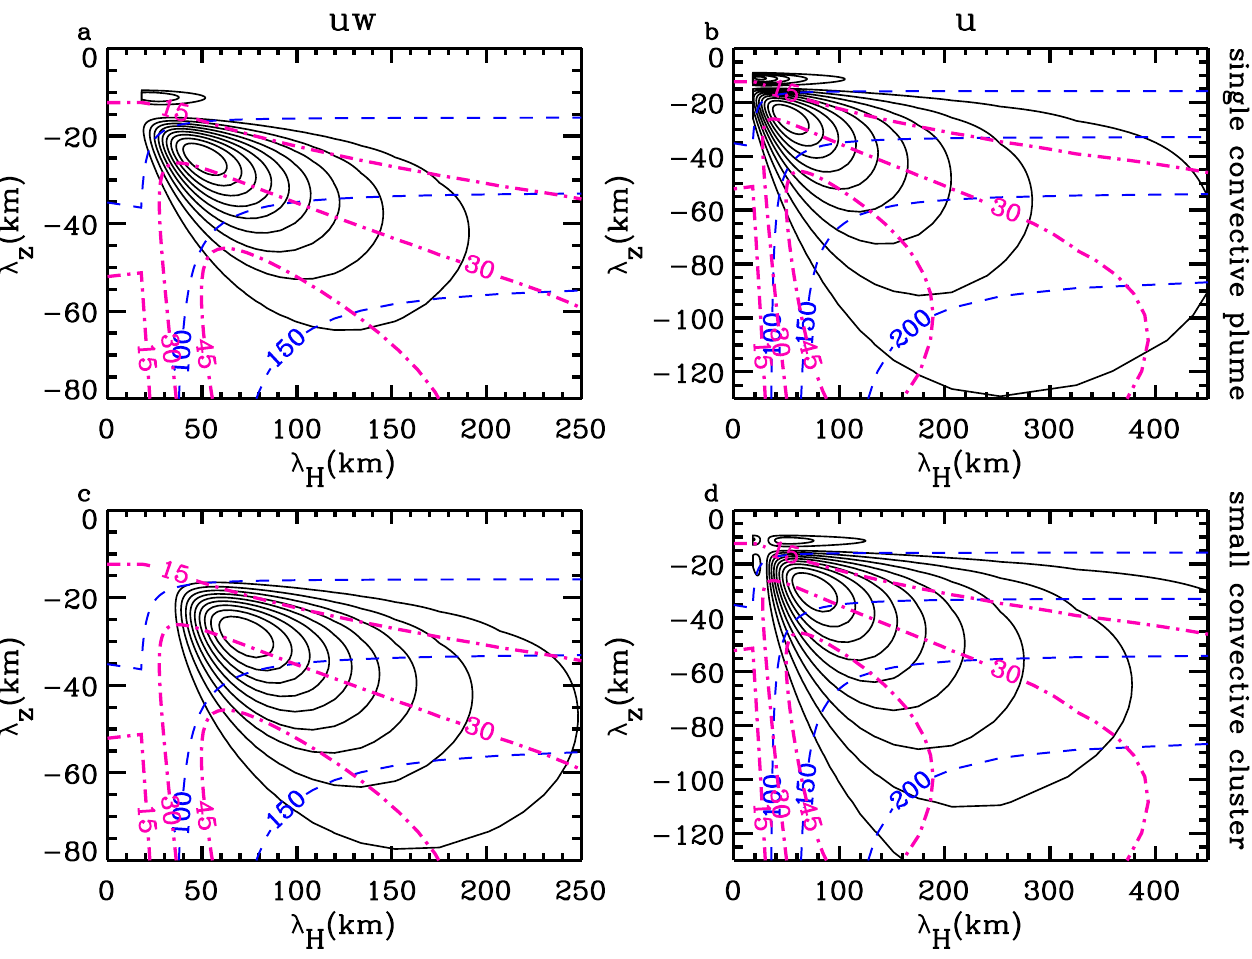
Fig. 4. Vertical flux of zonal momentum spectra (left column) and zonal velocity spectra (right column) in the forms given by Eqs. (35) and (36) as a function of λ H and λ z for upward and eastward propagating GWs (solid lines). Upper row: Single convective plume with ground reflection. Lower row: Small convective cluster with ground reflection. Contours are shown in intervals of 10% of the maximum. The maximum momentum flux and zonal velocity is ∼ 4 and ∼ 2 times larger for the small convective cluster than for the single convective plume, respectively. Pink dash-dot lines indicate c gz in 15m / s intervals. Blue dash lines indicate c H in 50m / s intervals. The resolution is 1x = 8 .